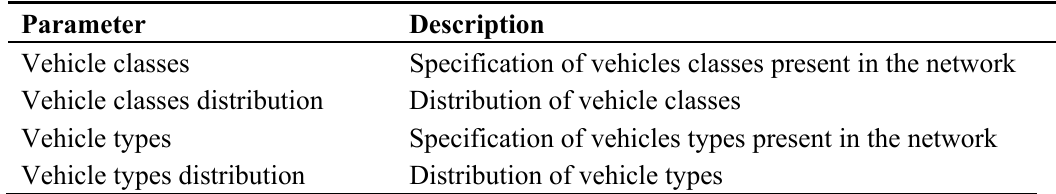
Table 4. EVeSSi classes and types parameters.